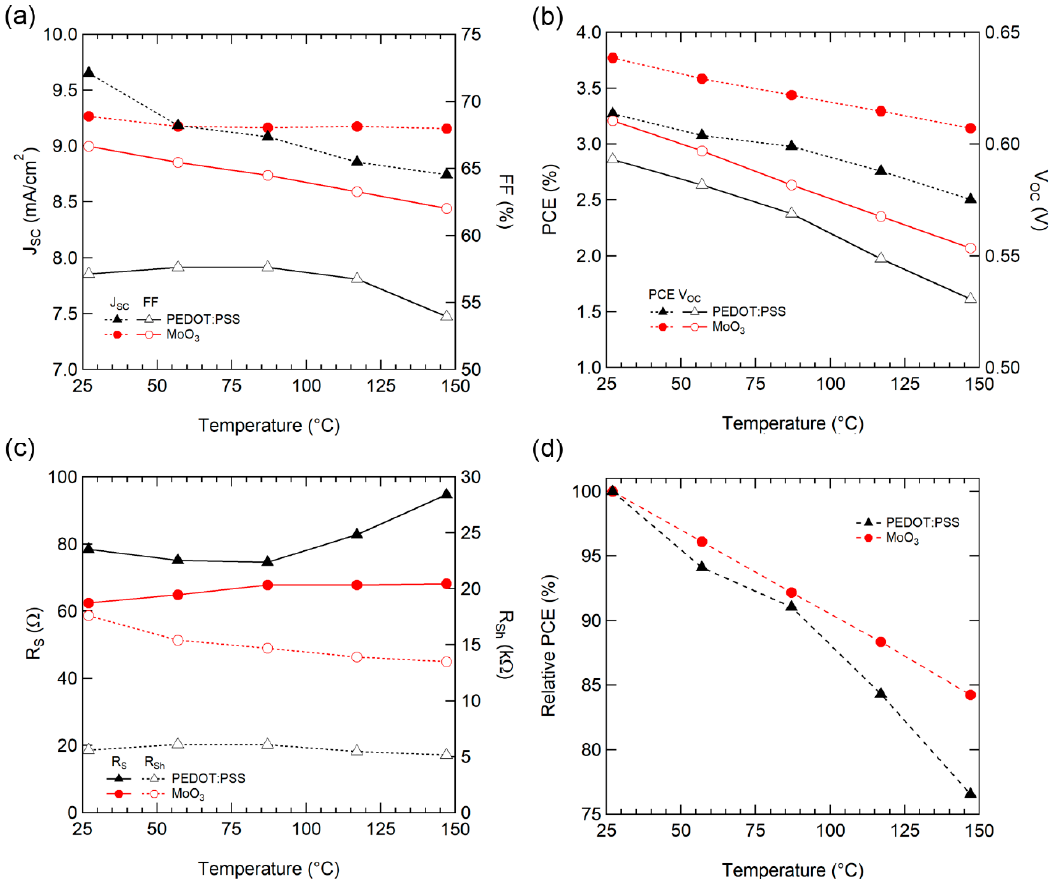
Figure 3. ( a ) J SC and fill factor (FF), ( b ) power conversion efficiency (PCE) and V OC , ( c ) R S and R Sh , and ( d ) Normalized PCE characteristics of OSCs with various temperatures.